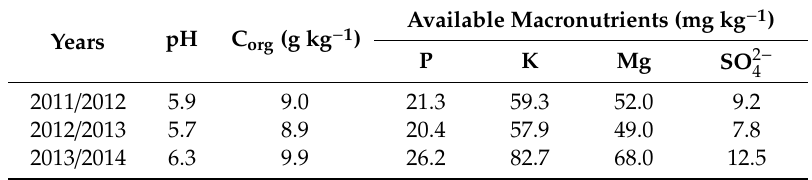
Table 1. Chemical properties of